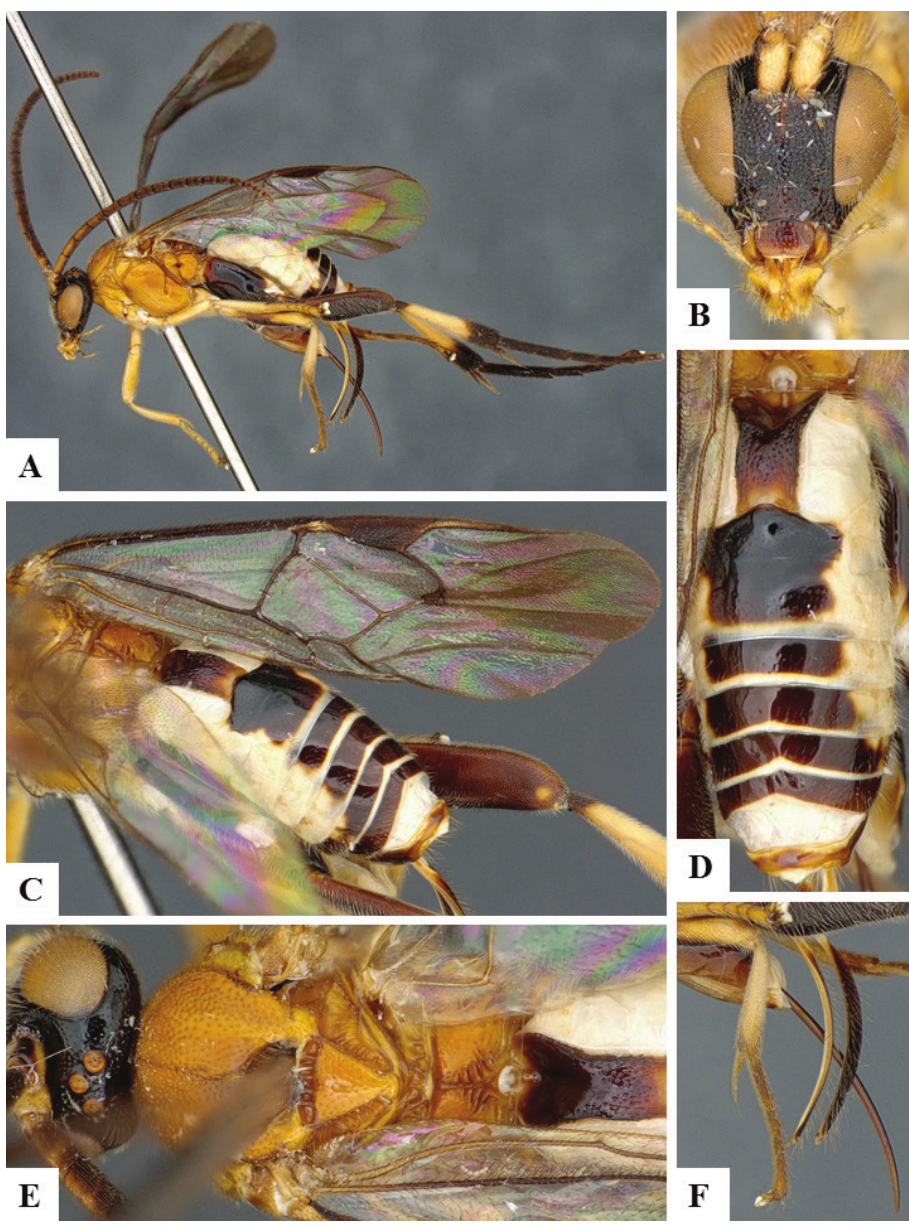
Figure 1. Agupta danyi female holotype. A Habitus B Head frontal C Fore wing D Metasoma dorsal E Head and mesosoma, dorsal F Ovipositor and ovipositor sheaths. setose and about same length of metatibia. Female body measurements (mm). F2 L: 0.45 (0.40–0.43); F3 L: 0.43 (0.38–0.41); F14 L: 0.25 (0.22–0.24); F15 L: 0.22 (0.20–0.23); Malar sulcus L: 0.12 (0.12–0.13); Mandible W: 0.23 (0.20–0.23);